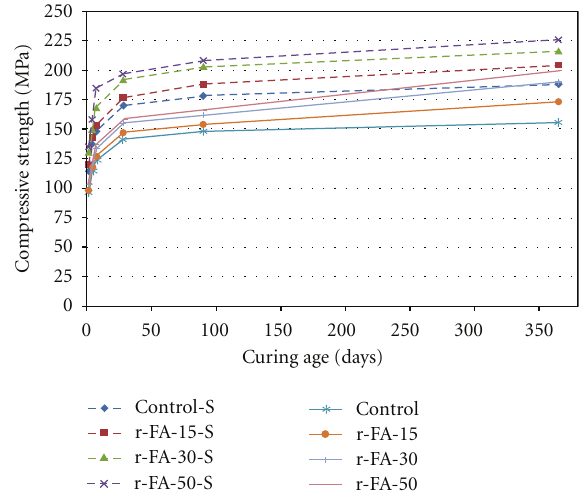
Figure 3: E ff ect of r-FA on compressive strength of UHPFRC with and without steam